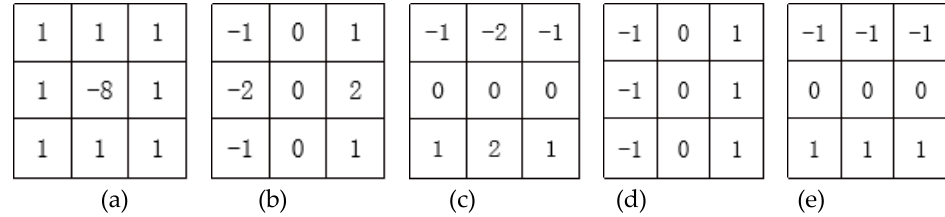
Figure 22. Convolutional kernels of the third convolutional layer: ( a ) gradient Laplacian convolutional kernel, ( b ) horizontal Sobel convolutional kernel, ( c ) vertical Sobel convolutional kernel, ( d ) horizontal gradient convolutional kernel, ( e ) vertical gradient convolutional kernel.